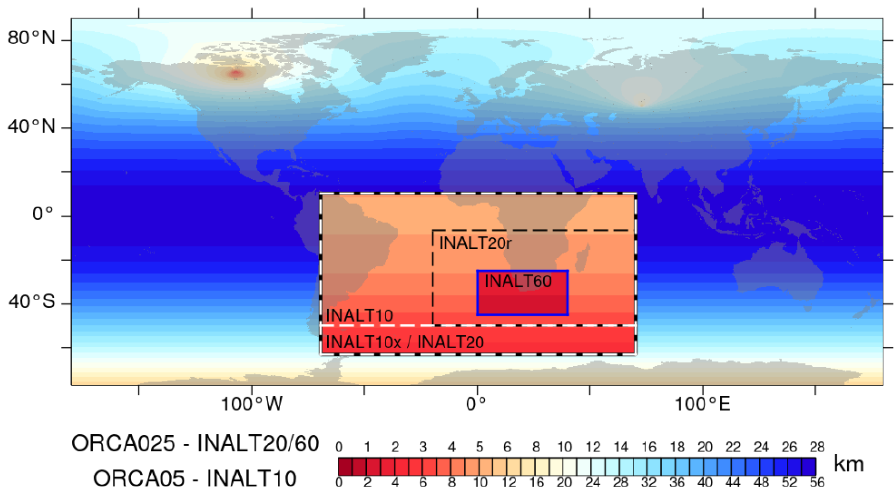
Figure 2. Grid sizes in the INALT family: shown is the zonal grid length (in km) for the global ORCA025 grid with the embedded INALT20 (outer black box), INALT20r (inner black box) and INALT60 (blue box) grids (upper scale), as well as for ORCA05 with the embedded INALT10x (white dashed box, same as INALT20) and INALT10 with its southern boundary shifted north (lower scale). Table 1. Grid sizes, time steps for hosts (h) and nests (n1) as well as the secondary nest in INALT60 (n2), and grid point integrations per model day (GPIPD) are given for the individual configurations. The computational requirements in nodes consisting of 24 CPUs each, for the model code itself (NEMO) and the input–output server (XIOS), and CPU hours (per model year) are estimated on a Cray XC40, equipped with Intel Xeon Haswell processors, at the North-German Supercomputing Alliance (“Norddeutscher Verbund für Hoch- und Höchstleistungsrechnen”;